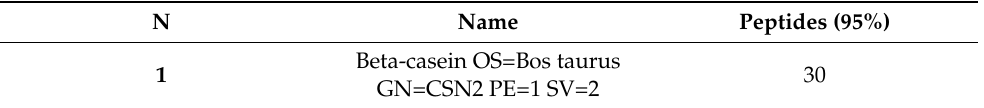
Table 3. Results of the MS analysis polypeptide from peak 2. Matched peptides were identified with more than 95%